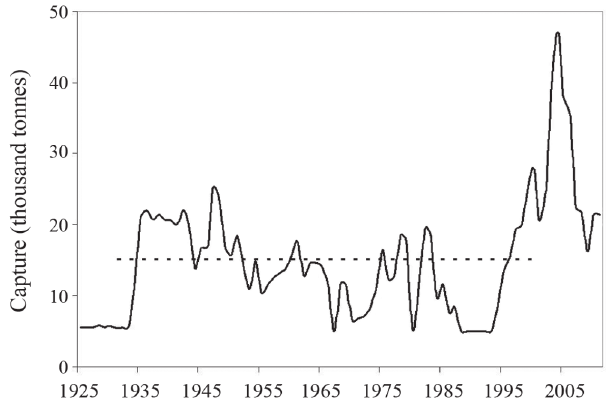
Fig. 2. Capture records of sábalo in the Paraná basin. The data taken from 1920 to 1988 were compiled by the National Agency of Freshwater Fisheries. The data from 1994 to 2009 correspond to the exportation records of the Sanitary National Service (SENASA). No data from 1988 to 1993 were